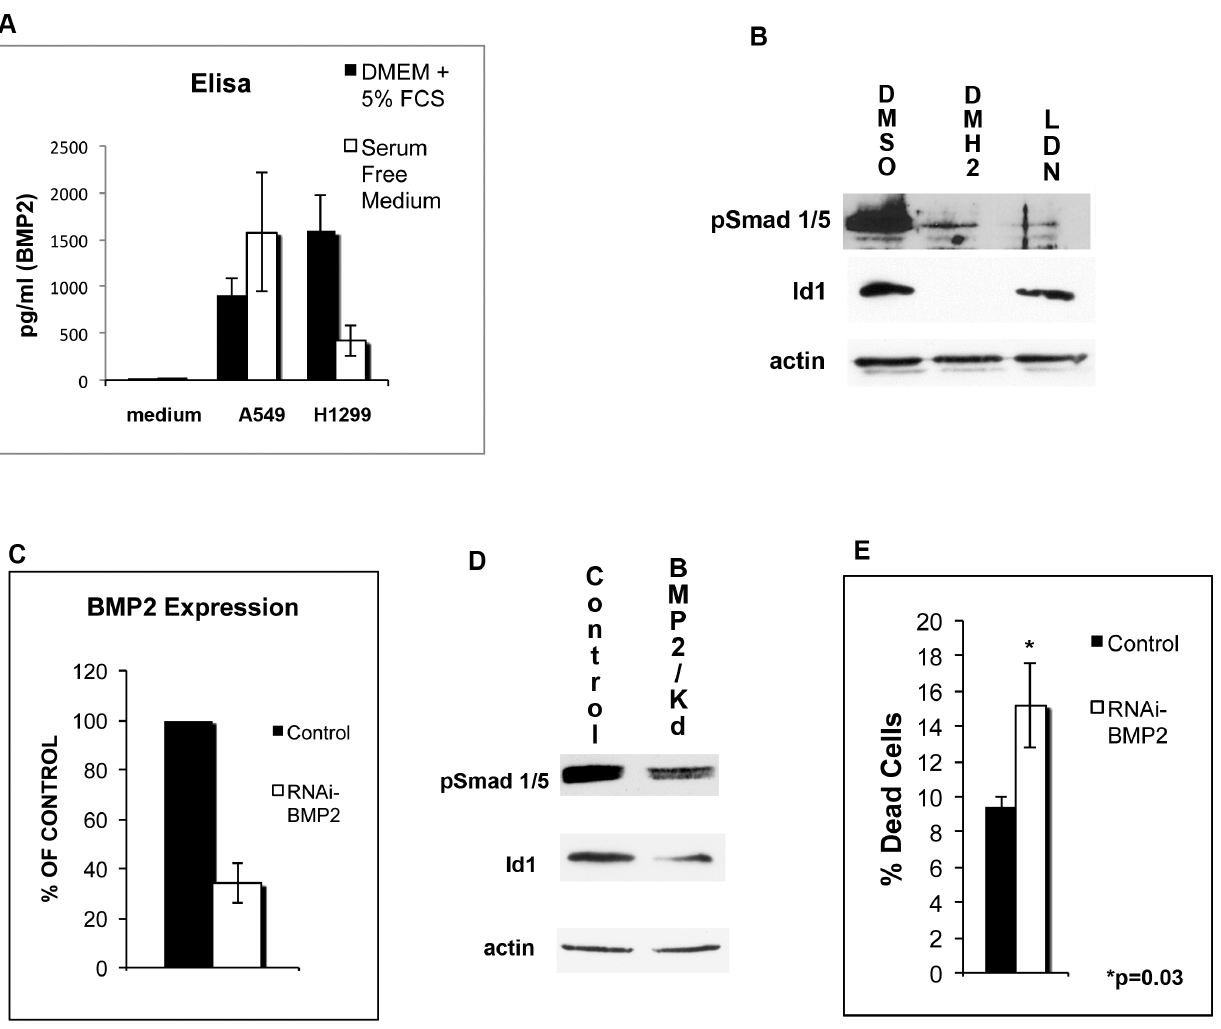
Figure 6. Lung cancer cell lines secrete BMP2 and knockdown of BMP2 decreases BMP signaling and induces cell death. ( A ) A BMP2 Elisa was performed on the DMEM 5% FCS and SFM in the absence of cells (medium). A BMP2 Elisa was performed on the DMEM 5% FCS and SFM cell culture medium containing A549 and H1299 cells for 48 hours. Experiments represent the mean of at least 5 experiments performed in triplicate. ( B ) BMP antagonists decrease BMP signaling of lung cancer cells cultured in SFM. H1299 cells cultured in SFM were treated with 1 m M DMSO, 1 m M of DMH2 or 1 m M of LDN for 48 hours and Western blot analysis performed. ( C ) Quantitative RT-PCR for BMP2 expression 48 hours after transfecting H1299 cells with control siRNA or siRNA targeting BMP2. Data represents the percent of control of the average of 4 independent experiments. ( D ) Western blot analysis of H1299 cells in SFM 48 hours after being transfected with control siRNA or siRNA targeting BMP2. BMP2 knockdown causes a decrease in expression of pSmad 1/5 and Id1. ( E ) Knockdown of BMP2 induces cell death. H1299 cells in SFM were transfected with control siRNA or siRNA targeting BMP2. After 48 hours the percentage of dead cells was determined by ethidium bromide staining. The data represents the mean of 4 independent experiments performed in